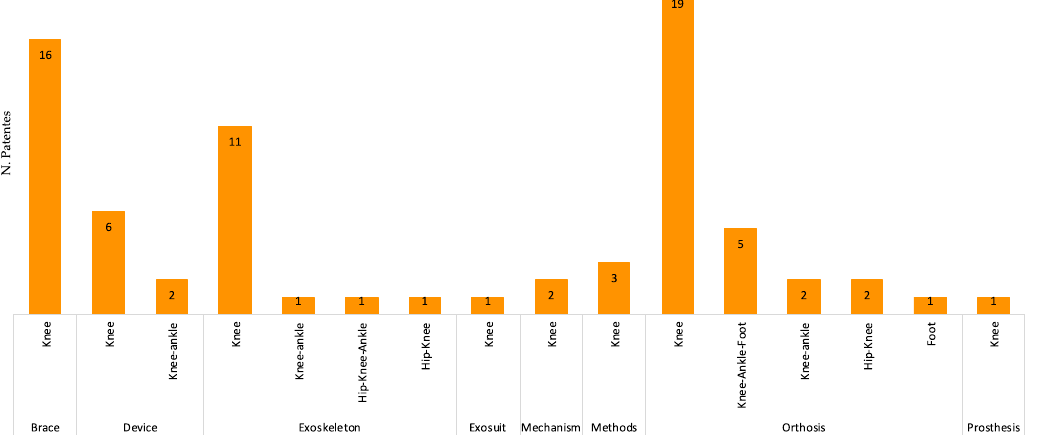
Figure 7. Description of the patents and main coverage.